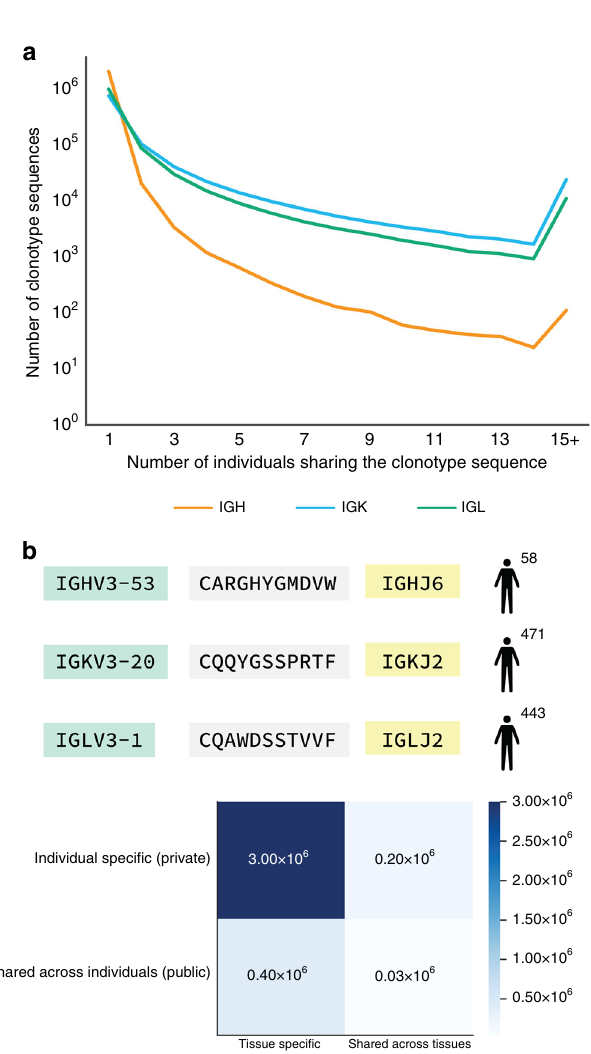
Fig. 4 Private and public Ig clonotypes. a Distribution of frequencies of private ( n = 1) and public ( n > 1) clonotypes across 544 individuals. We collect clonotypes from all tissues of the same individual and combine clonotypes into a single set corresponding to that individual. b The most public clonotypes (shared across the maximum number of individuals) and corresponding VJ recombination are presented for IGH, IGK, and IGL. c Clonotypes ’ sequences are classi fi ed into public (shared across individuals) clonotypes, private (individual-speci fi c) clonotypes, tissue- speci fi c clonotypes, and clonotypes shared across multiple tissues. The number of clonotypes falling into each pair of categories is reported. Source data for a and c are provided as a Source Data fi